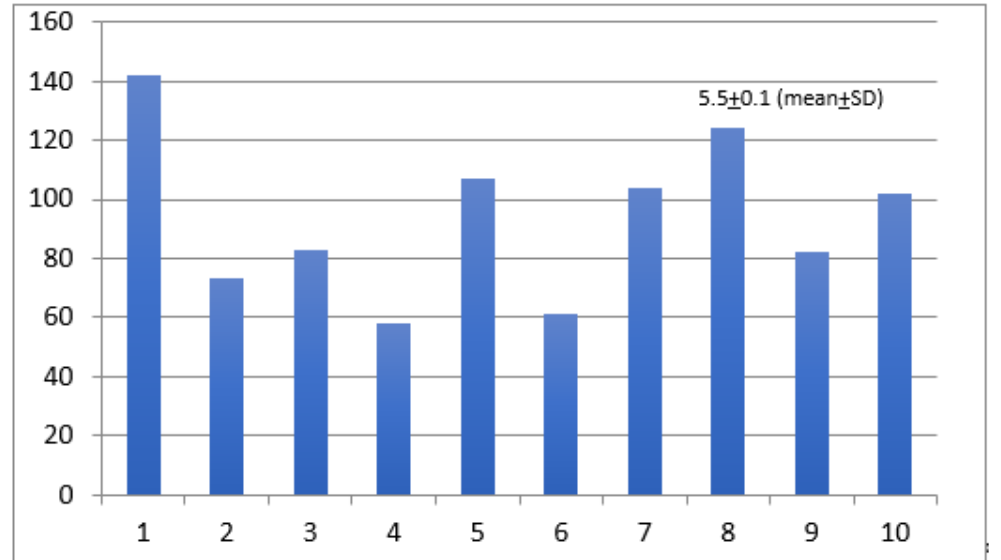
Figure 4. Support from medical institutions in regards to the protection of physical integrity in the workplace. Likert Scale: 1 = no support, 10 = full support. Y -axis = number of responders.